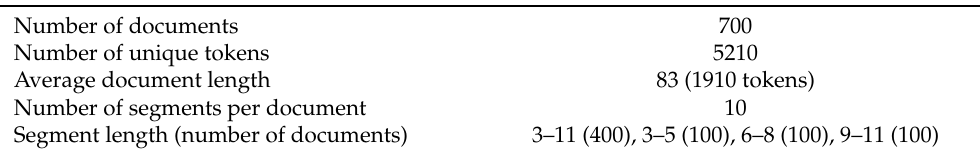
Table 1. Summary of the data used in the segmentation experiments (document and segment lengths are given in